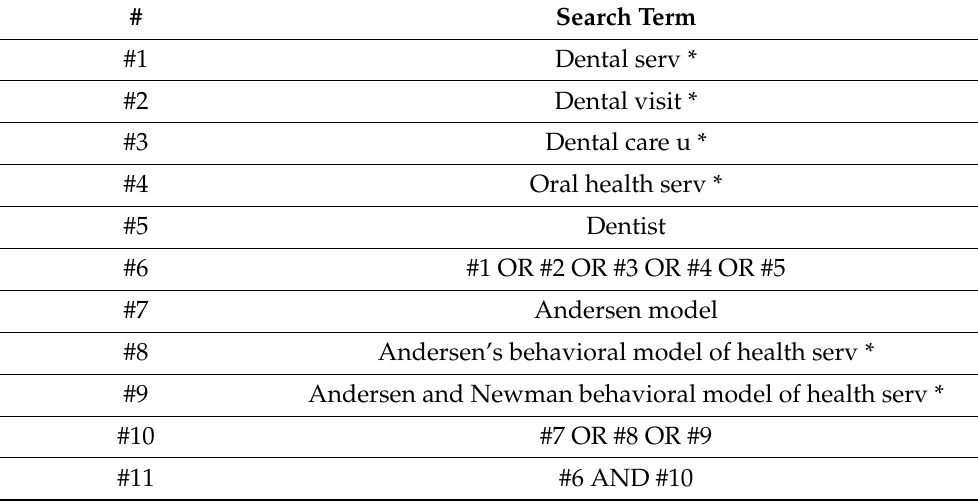
Table 1. Search strategy